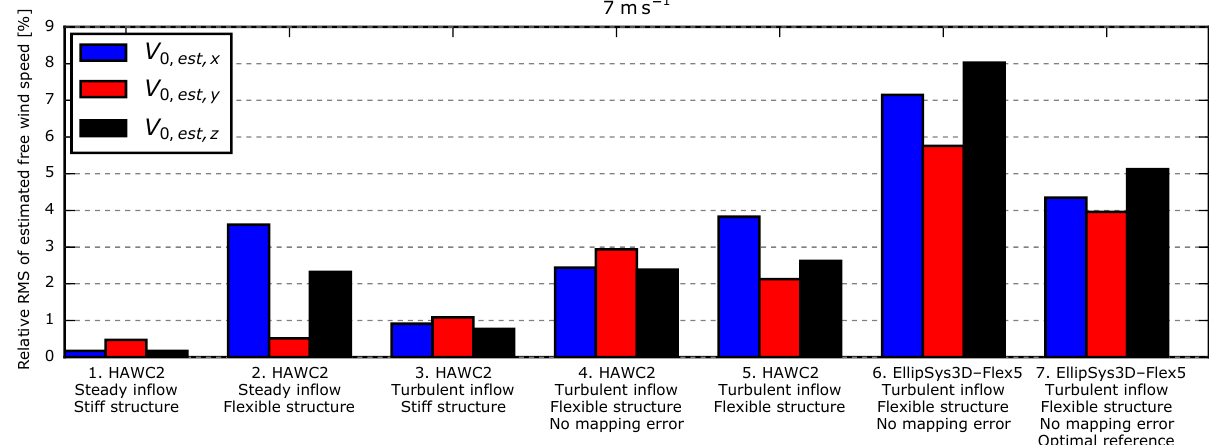
Figure 9. Relative RMS of the estimated free wind speed at 7ms − 1 . For Cases 4, 6 and 7, “no mapping error” means that deviations introduced in the transformation from the deflected blade-section coordinates to the fixed ground coordinates are not included.